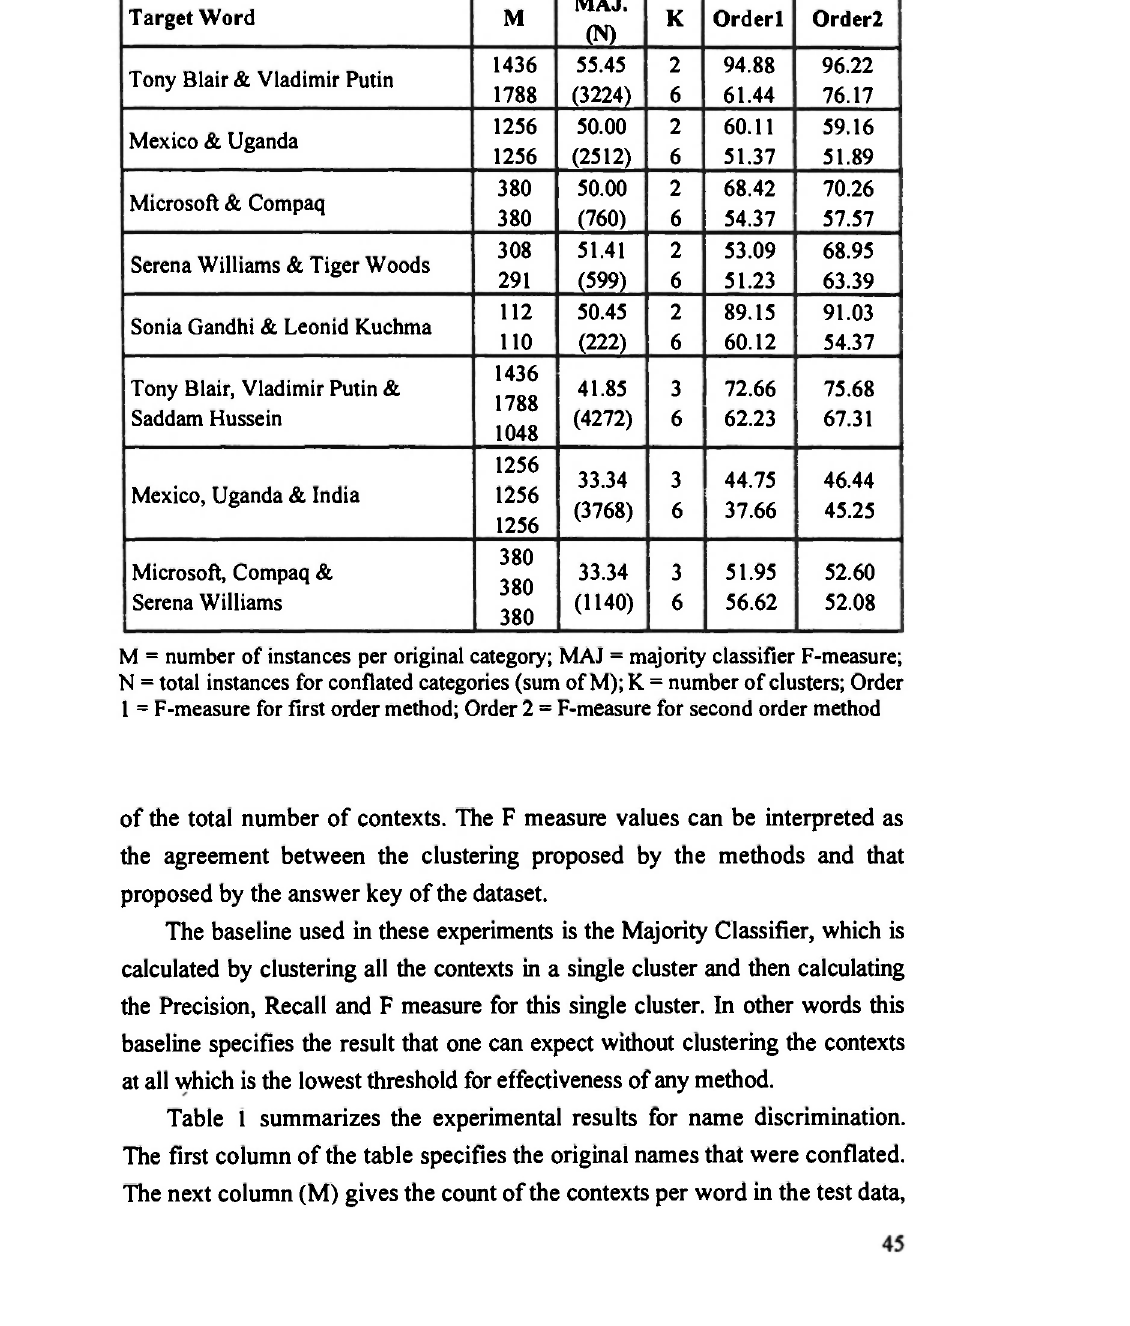
Experimental Results for name discrimination in terms of F